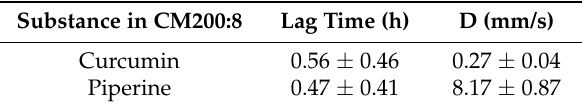
Table 2. Lag time (h) and diffusion coefficient (D) of curcumin and piperine released from the composite membrane (CM200:8) in PBS pH 7.4 at 37 ± 1 °C